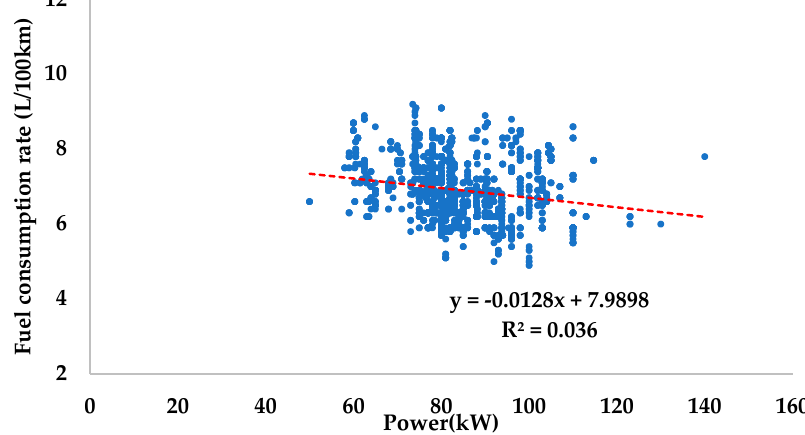
Figure 4. Regression results of power and fuel consumption rate of models in the 1200–1300 kg curb weight class.